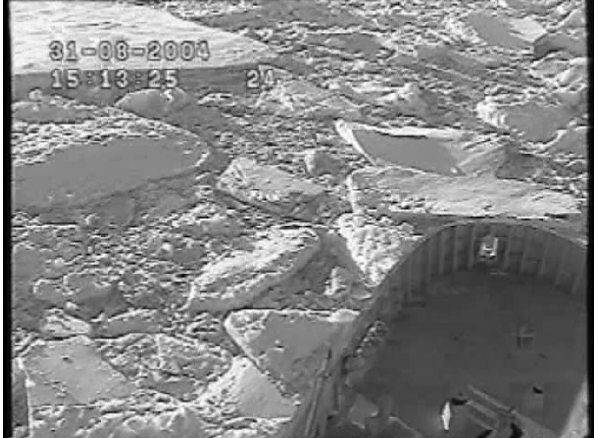
Figure 5: Bridge camera picture of surrounding ice condition of Icebreaker Vidar Viking during DP operation in the ACEX expedition on August 31, 2004. Courtesy: ACAC